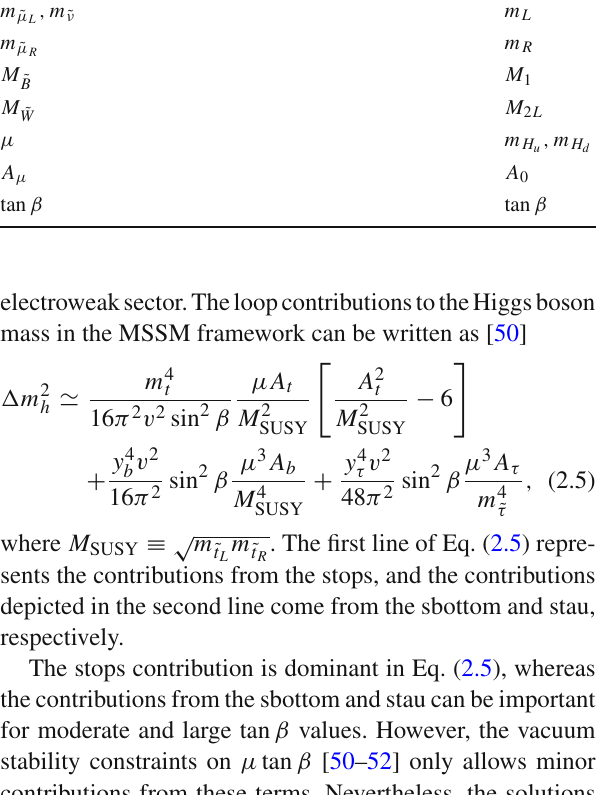
Table 1 The fundamental parameters determining the supersymmetric contributions to muon g − 2 at the low scale (left) and GUT scale (right) Low